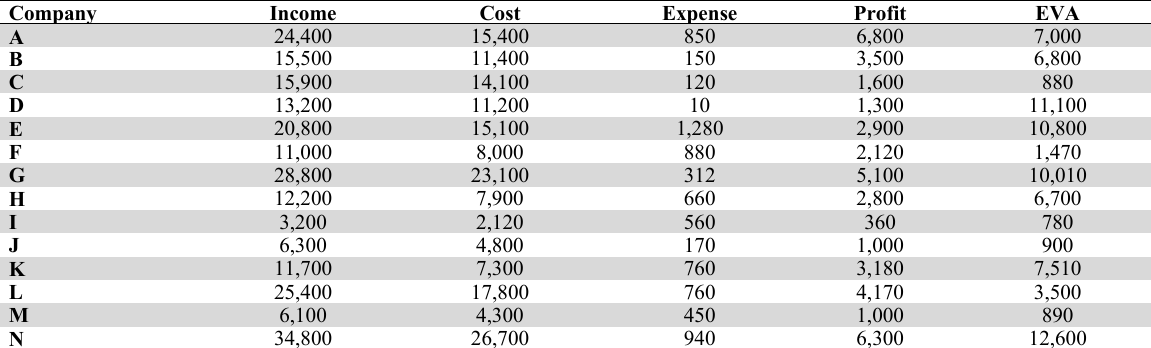
Training Samples